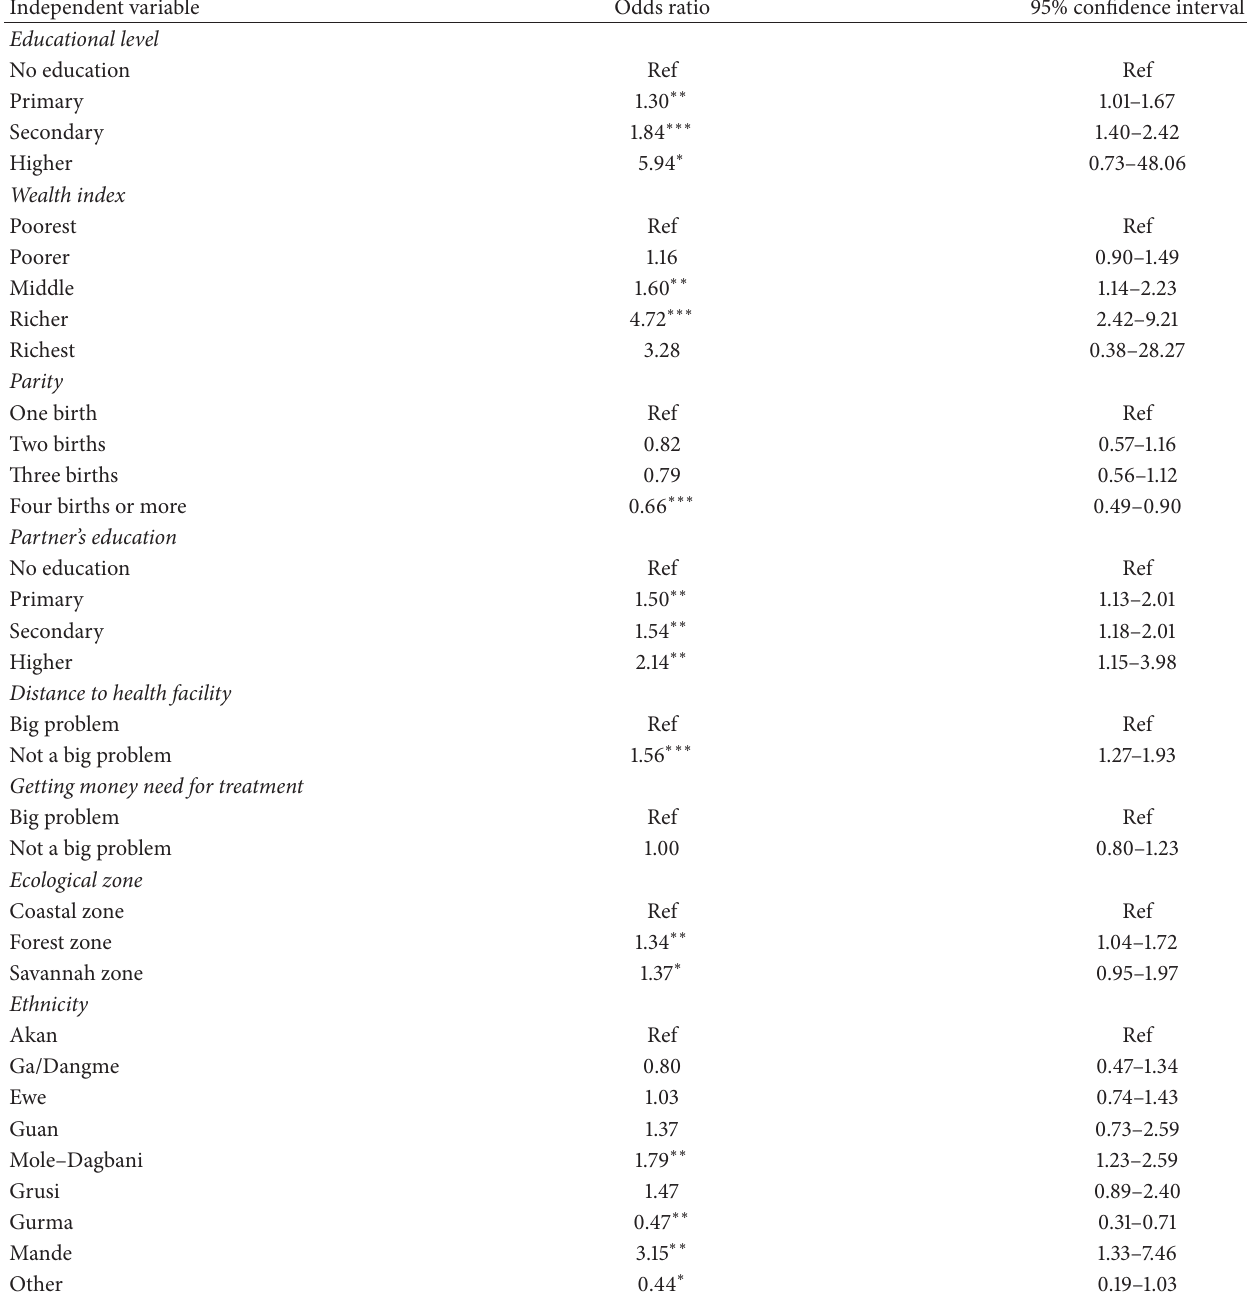
Table 2: Binary logistic regression on place of delivery among women in